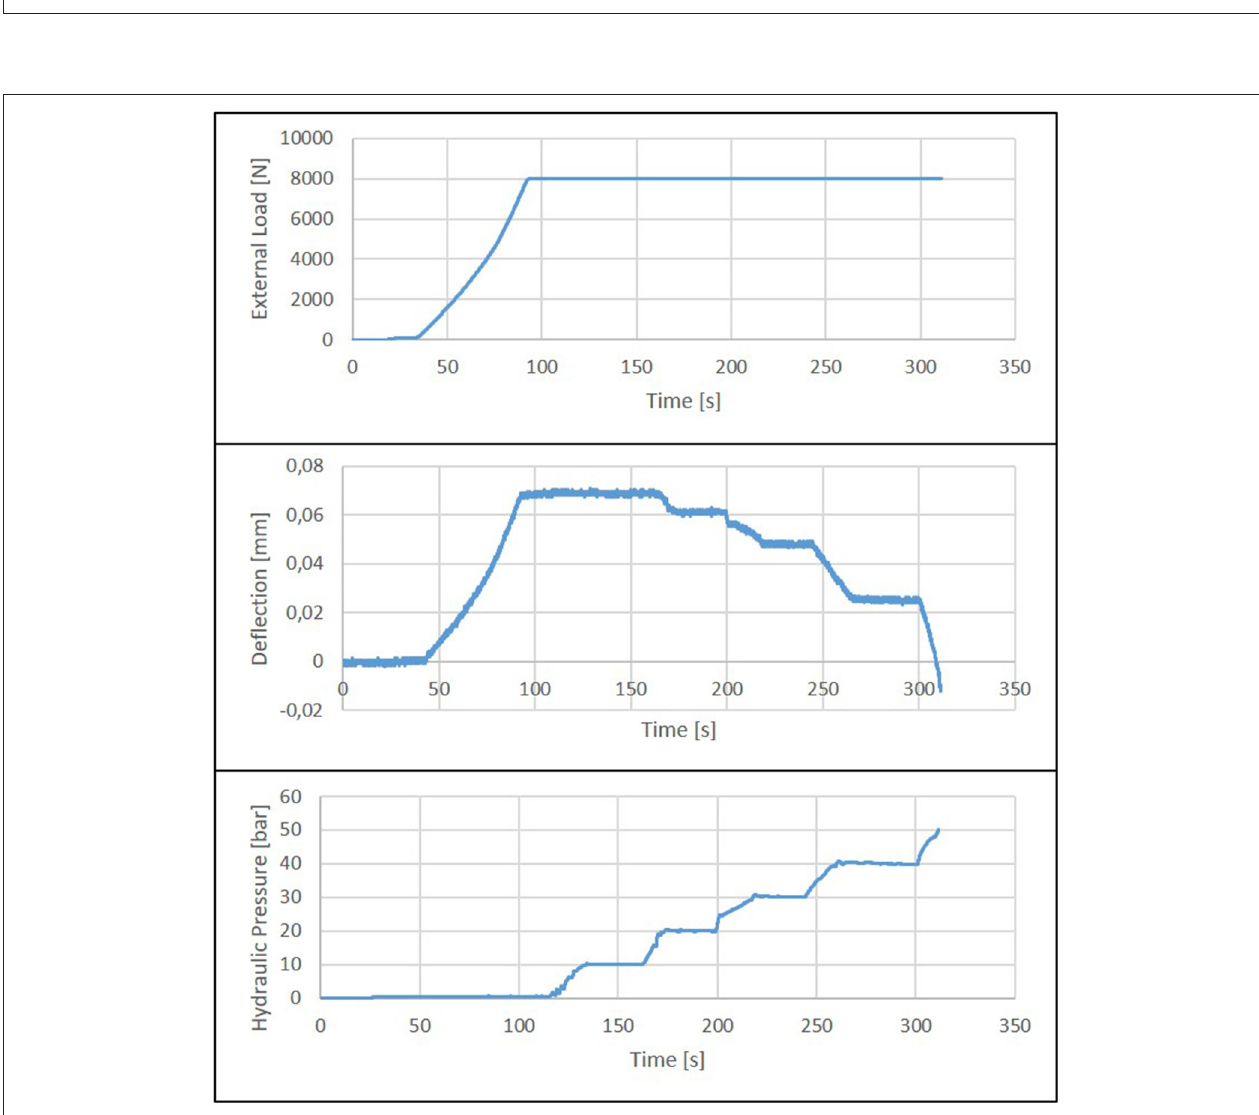
FIGURE 13 | Results of a four-point-bending test: external load (Top) , mid-span deflections of the beam (Mid) , hydraulic pressure inside the integrated actuators (Bottom) .